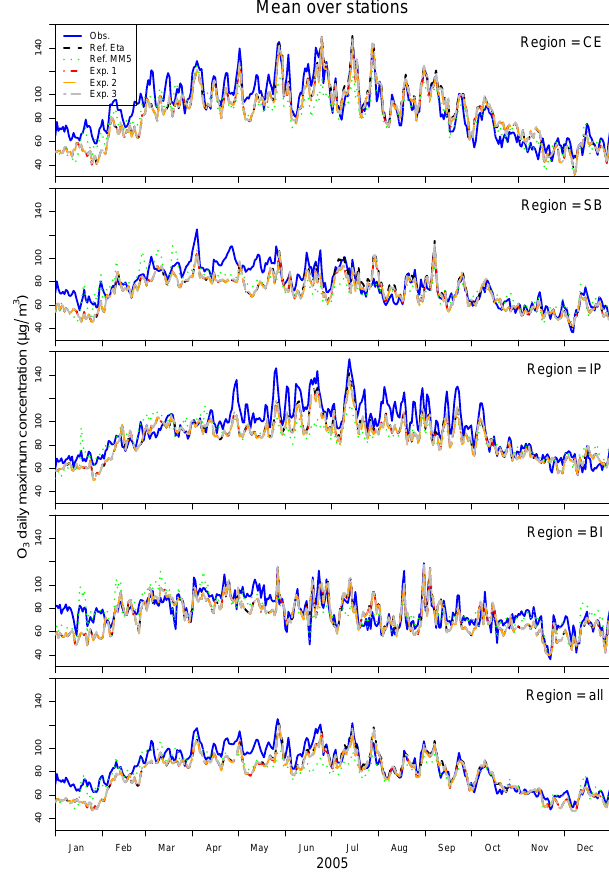
Fig. 9. Time series of daily-maximum O 3 concentrations for the Fig. 9. Time-series of daily-maximum O 3 concentrations for the different regions indicated in Fig. 1b. different regions indicated in Fig. 1b.